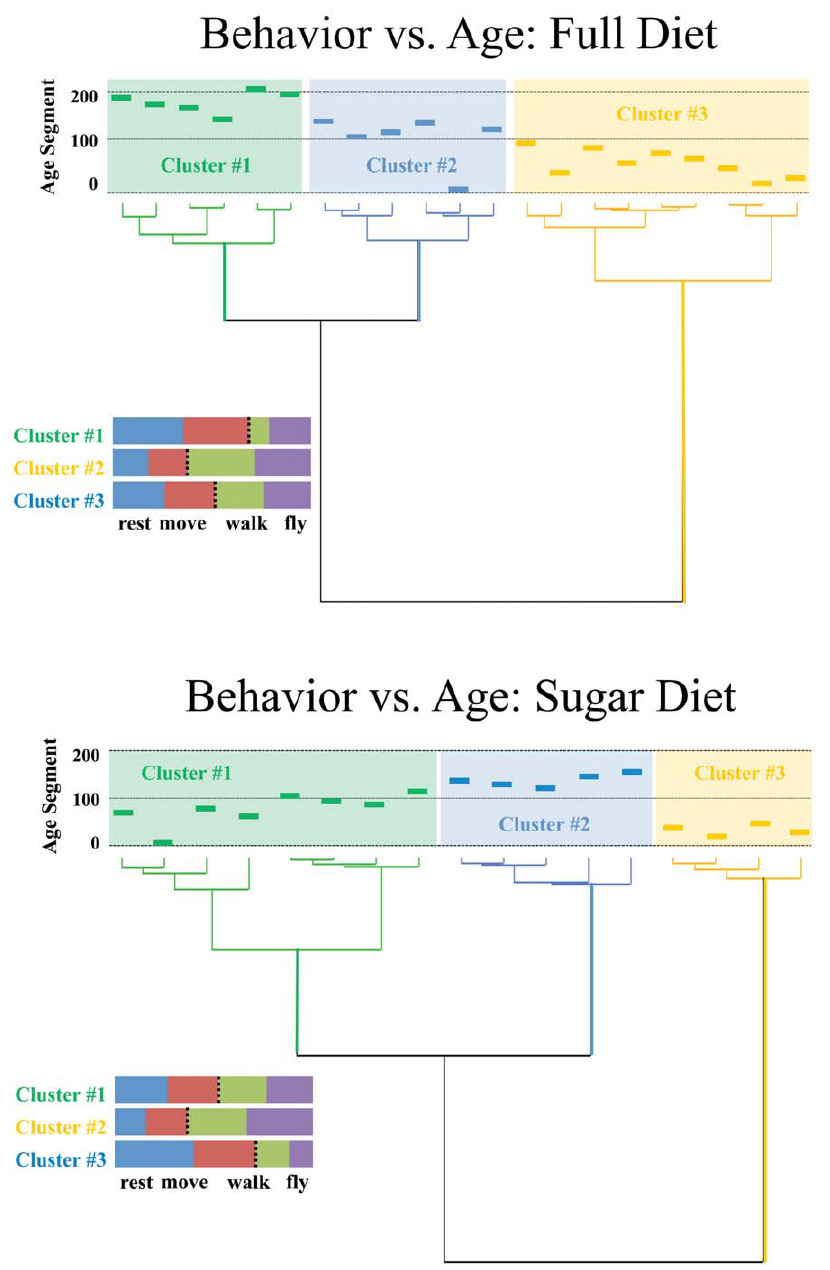
Figure 4. Dendrogram produced by software TraMineR showing the hierarchical clustering of age periods in A.ludens according to similarities in the lifetime behavior patterns. (A). Hietrarchical patterns for 16 females on full diet. The lengths of the branches connecting the internal nodes indicate degree of behavioral similarity and the leaf nodes represent elements of the behavior data (age intervals) used to construct the dendrograms. Each leaf in this graph represents the average behavior levels for the specified age range across all flies. These age classes are clustered by the Euclidean distance between their respective average behavior levels. The rectangles at the end of each ‘leaf’ (top of graphic) indicate the 10-day age intervals over which the behavior data was grouped and analyzed. The inset shows the relative differences in the frequency of each behavior that underlie the three clusters. Cluster # 1 consists of oldest age groups, Cluster # 2 for middle-aged groups and Cluster # 3 for young age groups. Note the between-cluster differences in the behavioral distributions to the left and right of the dashed vertical lines; i.e. the rank-order between clusters for the proportion of time walking and flying is: Cluster # 2 . Cluster # 3 . Cluster # 1. Conversely, the proportion of the time resting and micro-movement is: Cluster # 1 . Cluster # 3 . Cluster # 2. (B). Hierarchical patterns for 16 females on sugar-only diet. Cluster # 2 consists of oldest age groups, Cluster # 1 for middle-aged groups and Cluster # 3 for young age groups. The rank-order between clusters for the proportion of time walking and flying is: Cluster # 2 . Cluster # 1 . Cluster # 3. Conversely, the proportion of the time resting and micro-movement is: Cluster # 3 . Cluster # 1 . Cluster # 2. * p , 0.05, ** p , 0.01 and *** p , 0.001 indicates the similarity between age groups under a branch.